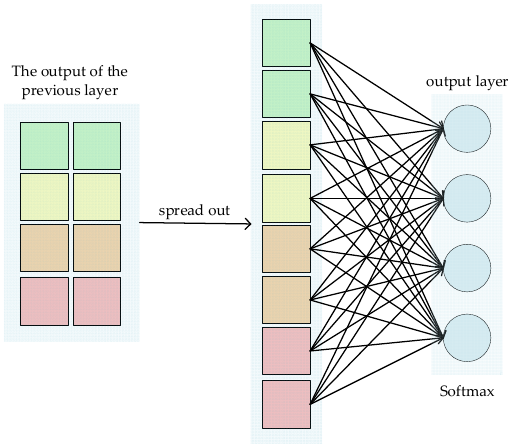
Figure 1. Flatten abridged general view.